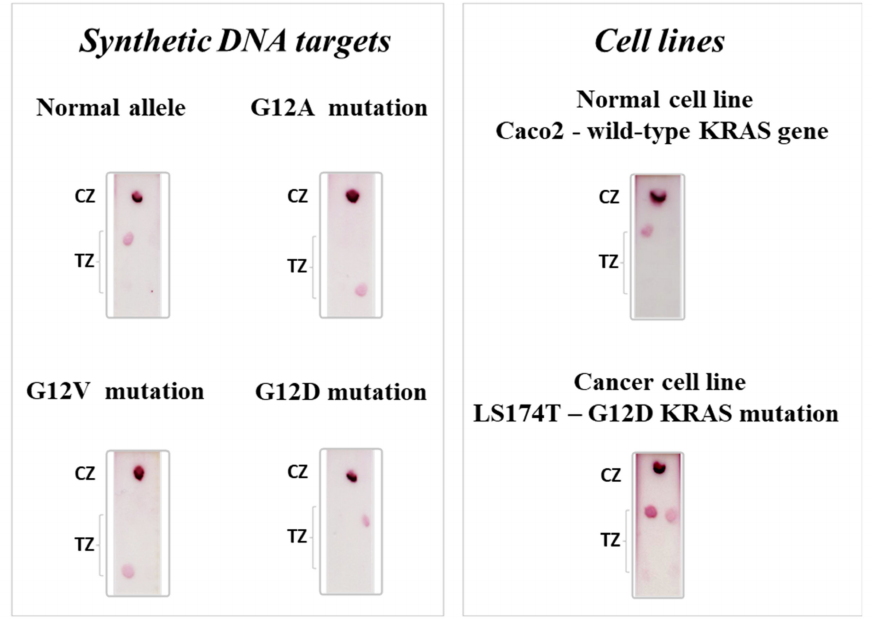
Figure 2. Results of the multiplex strip test for the synthetic DNA targets that correspond to the normal KRAS gene and the three single-point mutations examined. Results of the multiplex strip test for the cell lines that express the wild-type KRAS gene and the G12D KRAS mutant allele. TZ: test zone, CZ: control zone.